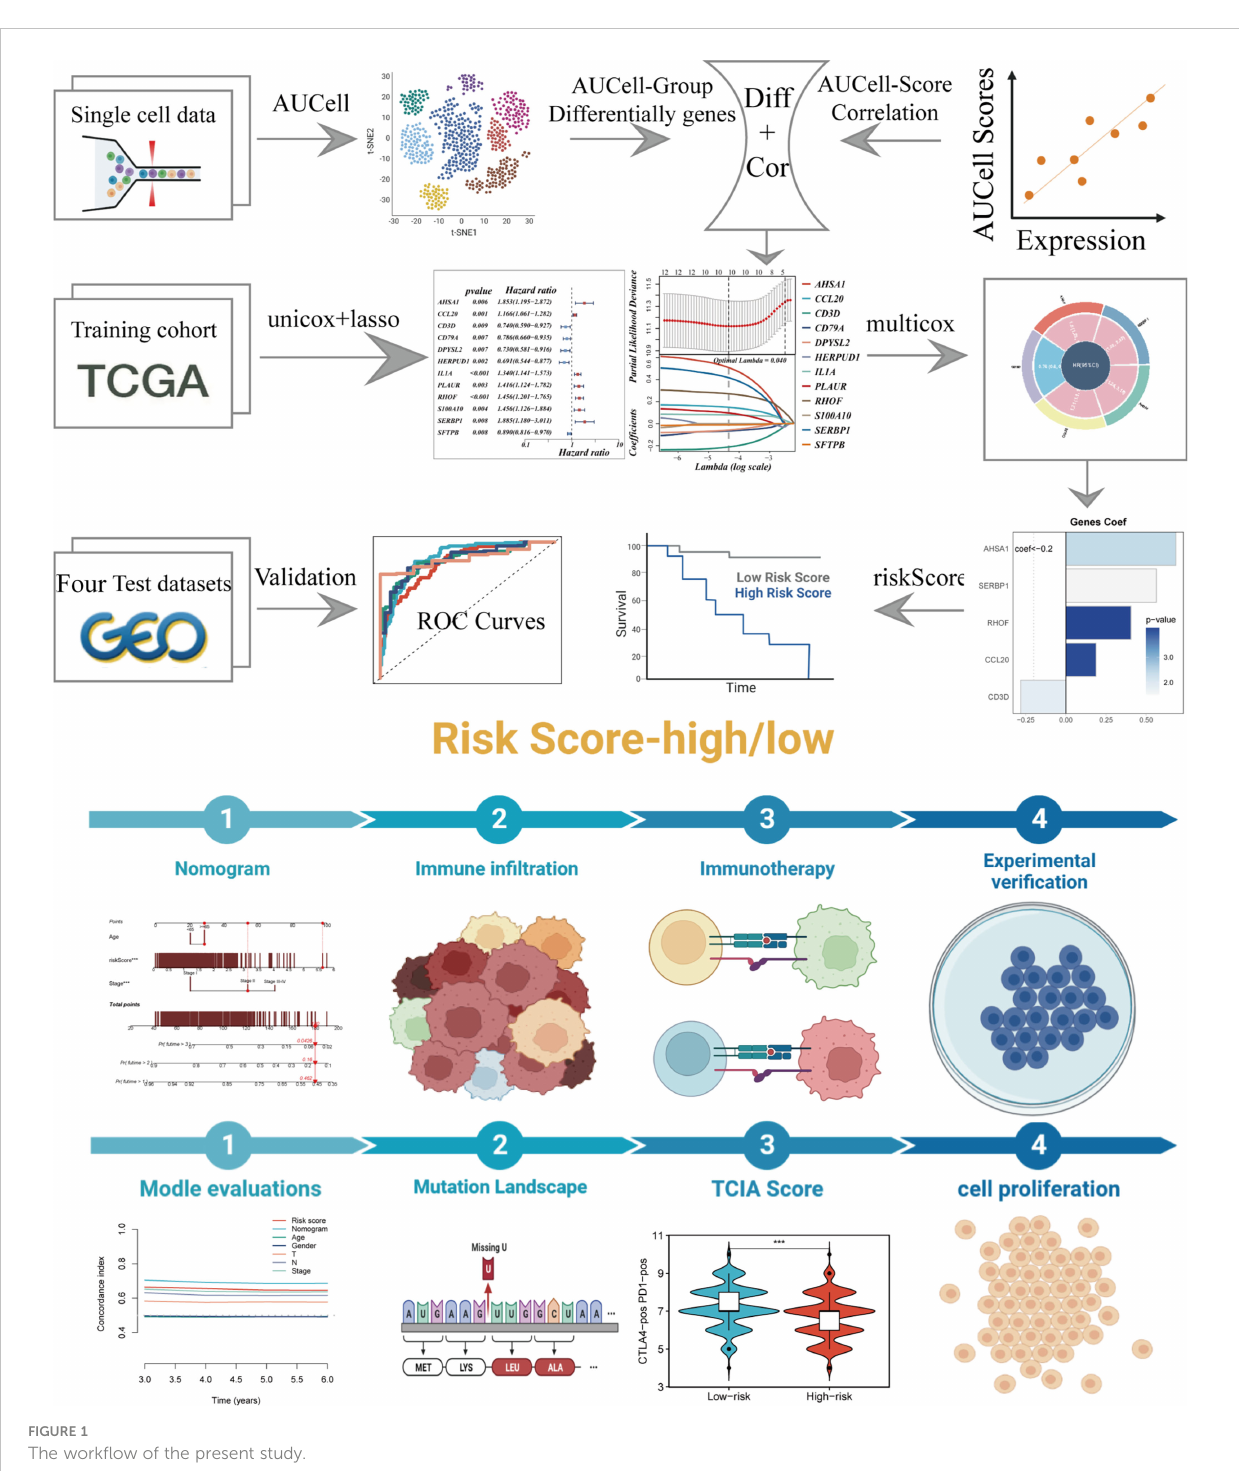
FIGURE 1 The work fl ow of the present